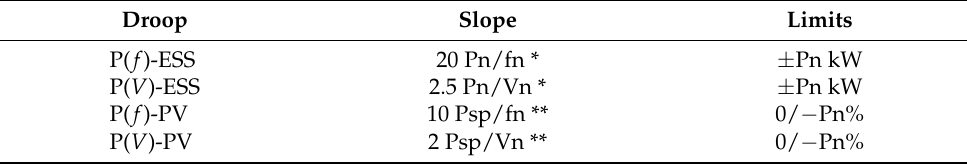
Table 5. Droop Controllers: Main characteristics. Droop Slope